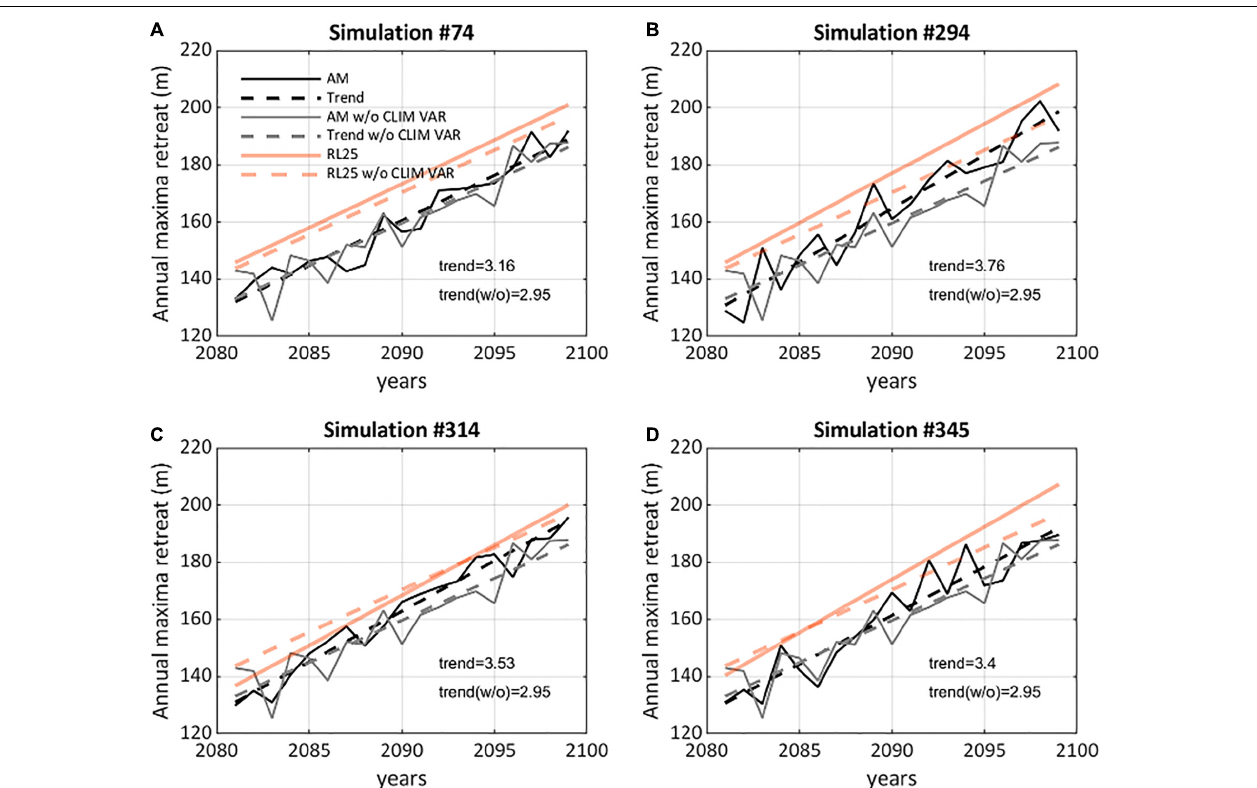
FIGURE 10 | Time series of annual maxima shoreline retreat corresponding to the IPSL-CM5A-MR model (solid grey line) and the simulations #74 (A) , #294 (B) , #314 (C) , and #345 (D) of SP1 associated with this GCM (solid black line). Dashed lines represent the annual maxima shoreline retreat trends. Effective 25-year return levels under the non-stationary assumption over 2080–2100 for the SLR 95th percentile and for the RCP8.5. The pink solid line shows the results of the SP1 simulation; and the pink dashed line represents the results associated with the original GCM simulation (SP3).